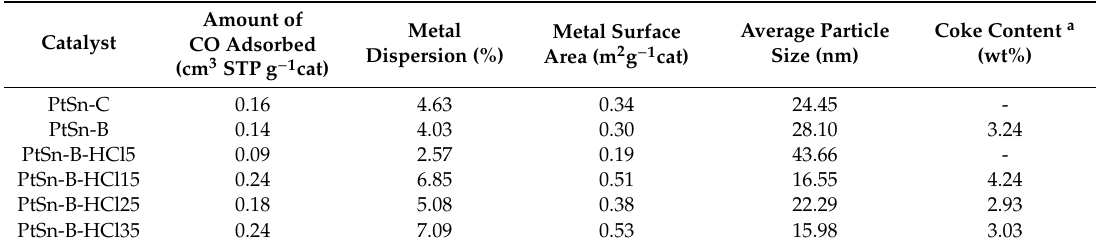
Table 2. CO chemisorption data for catalysts.